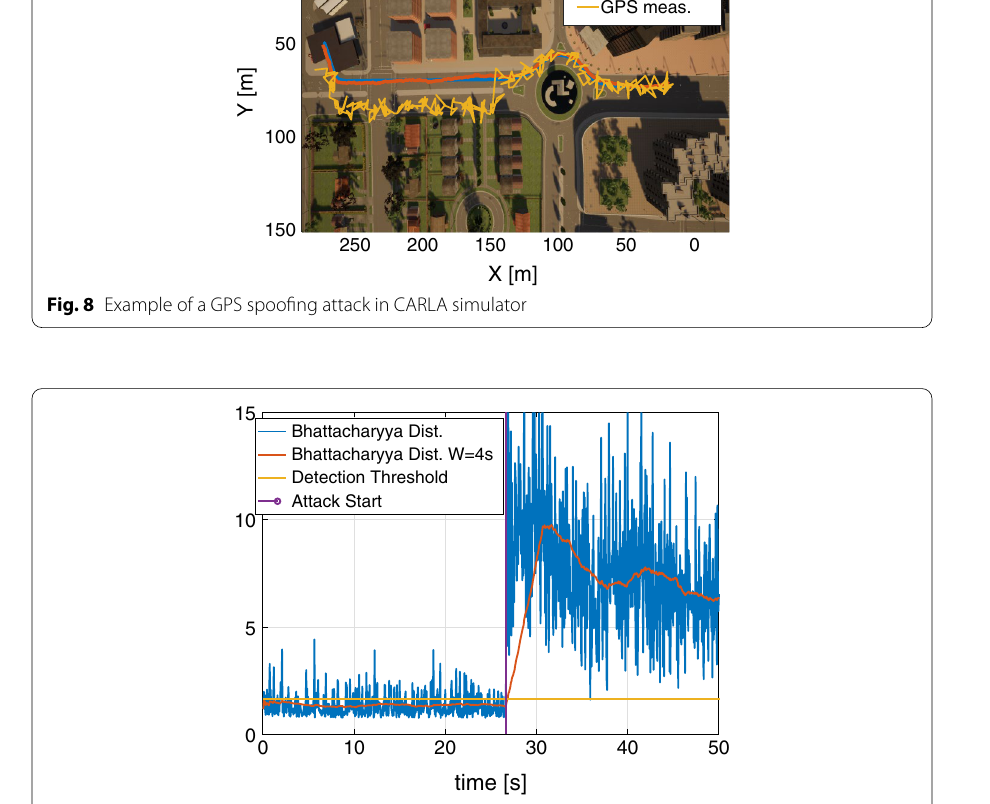
Fig. 9 Real‑time GPS spoofing attack detection exploiting a Bhattacharyya distance metric in CARLA simulator